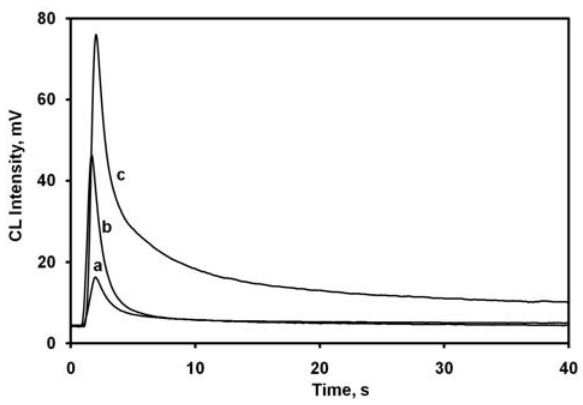
Figure 5. CL time profiles of a) blank (water), b) blank (human plasma), c) mepivacaine (45.25 μg mL –1 ) in human